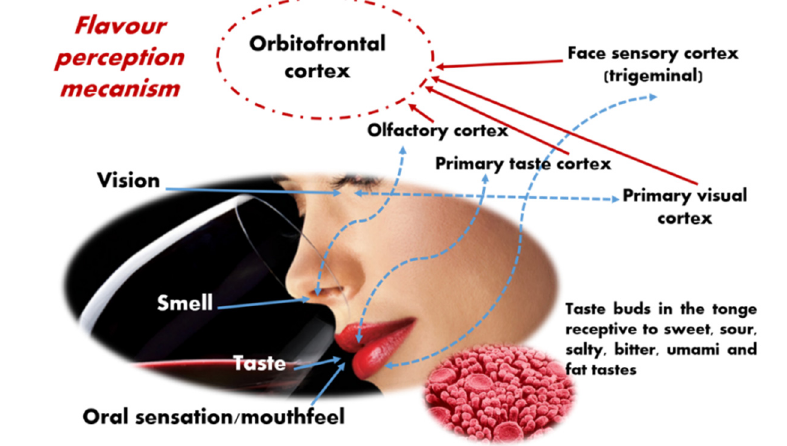
Figure 2. Mechanism of flavor perception in food and wine intake. Adapted from Redondo et al. [59].